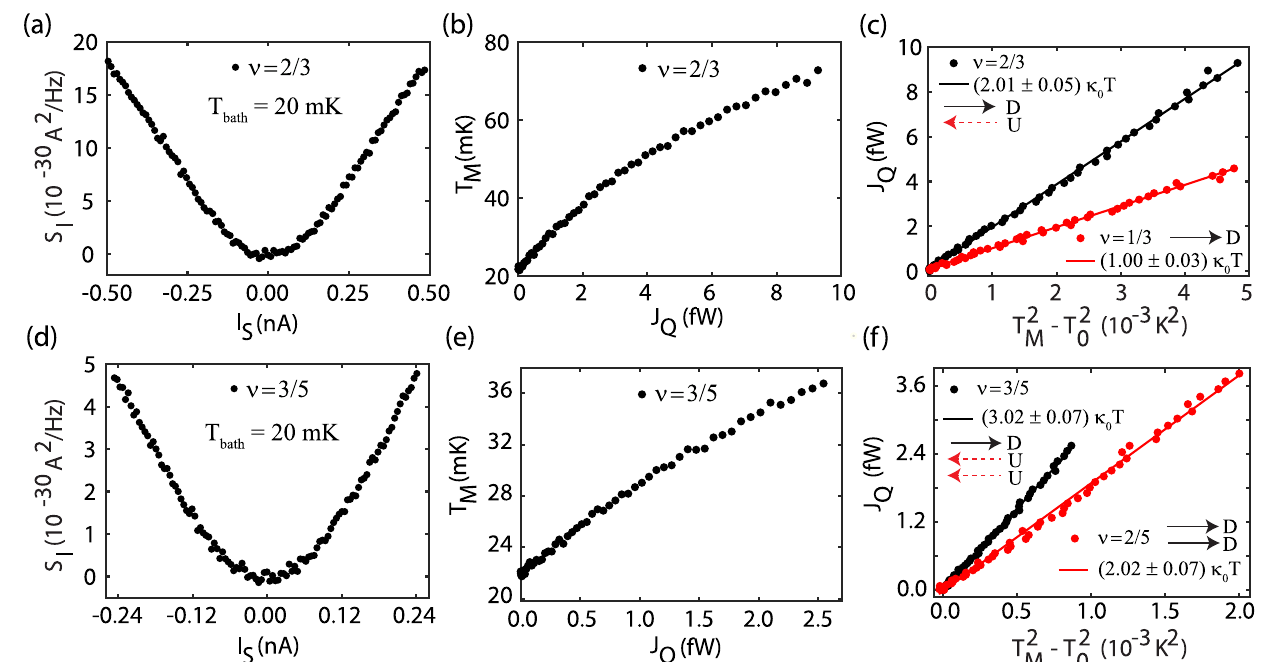
Fig.2|ThermalconductanceoffractionalQHstates.a Excessthermalnoise S I as current I S at ν =3/5. e Thetemperature T M ofthe fl oatingcontactasafunctionofthe a function of source current I S at ν =2/3. The DC currents I S and − I S were injected dissipated power J Q at ν =3/5. f J Q (solid circles) is plotted asa function of T 2 M (cid:2) T 2 0 for ν =3/5 (black) and 2/5 (red). Solid black and red lines are linear fi ts with G Q = simultaneously at contacts S 1 and S 2, respectively, as shown in Fig. 1d. b The 3.02 κ 0 T and 2.02 κ 0 T for ν =3/5 and 2/5, respectively . The black and dashed red temperature T M of the fl oating contact as a function of the dissipated power J Q at (cid:2) T 2 ν =2/3(black)and1/ ν =2/3. c J Q (solidcircles)isplottedasafunctionof T 2 arrows depict the downstream and upstream modes, respectively, for each edge M 0 at 3 (red). Solid black and red lines are linear fi ts with G Q =2.01 κ 0 T and 1.00 κ 0 T for structure. ν =2/3 and 1/3, respectively. d Excess thermal noise S I as a function of source